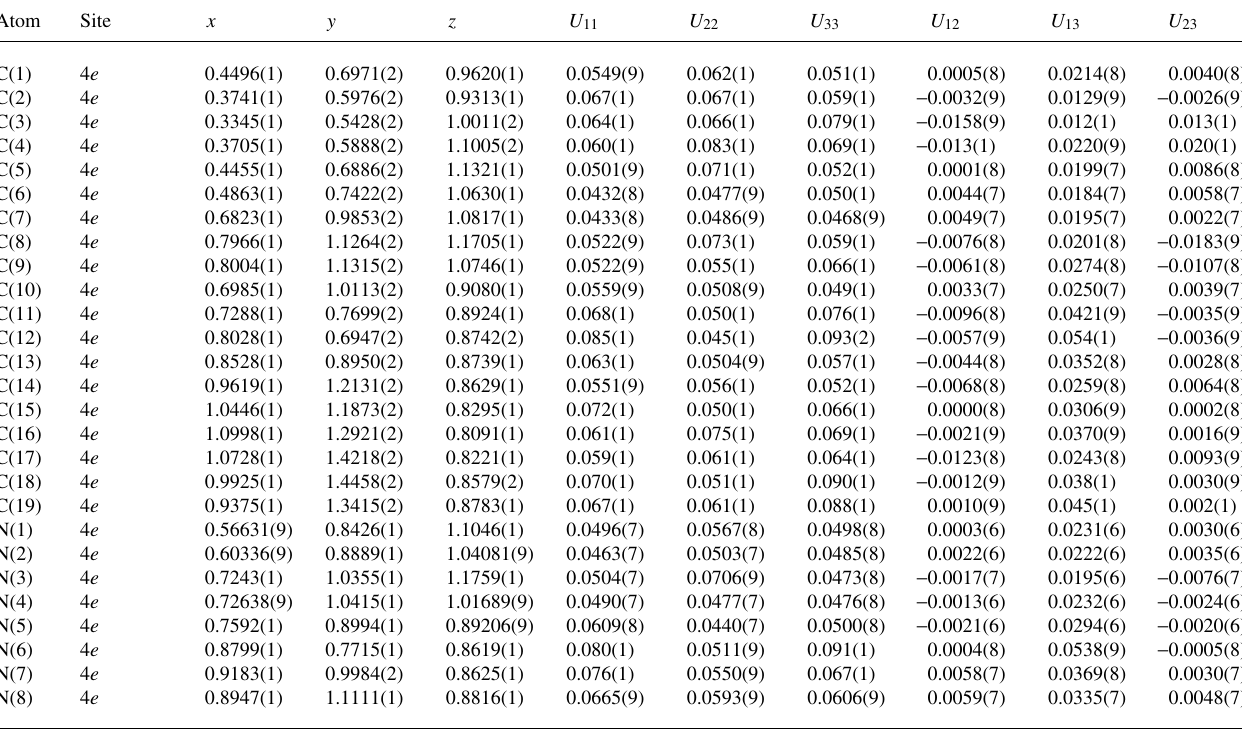
Table 3. Atomic coordinates and displacement parameters (in Å 2 )